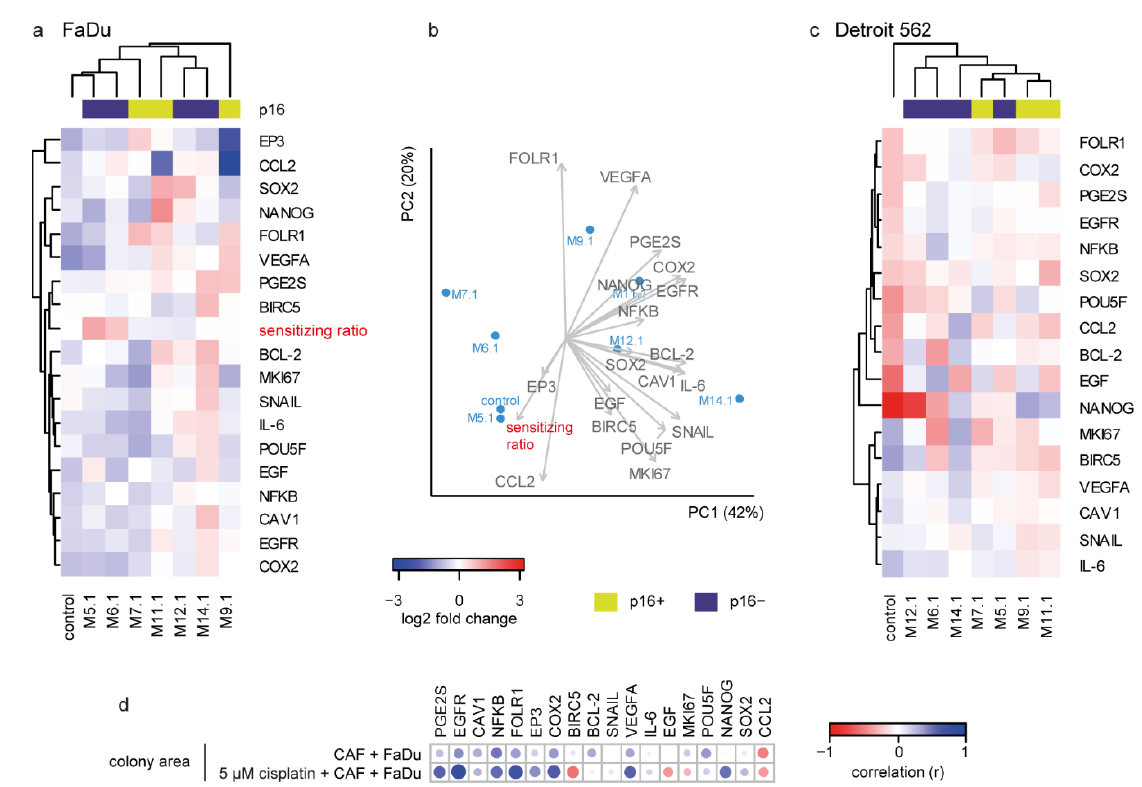
Figure 4. Effect of cisplatin on gene expression and its association with sensitizing ratio. ( a ) Heatmap of gene expression shown as a log2 fold change relative to individual CAF cocultured cisplatin untreated FaDu cells (to remove the among-CAF effect, the gene expression after coculture with each CAF (without cisplatin) was pairwise set as 0). The cisplatin effect on FaDu cell gene expression was CAF-specific and fell into two clusters: a cluster of CAFs M.5.1, M.6.1, and M.7.1 together with the non-cocultured control caused a general expression decrease and increase of cisplatin sensitivity, while M.11.1, M.12.1, and M.14.1 coculture resulted in the opposite; an increase in most of the studied genes and decreased/unchanged sensitizing ratio. ( b ) Principal component analysis of FaDu-cocultured cells. Colony-forming-based “sensitizing ratio”, EP3, and CCL2 were clustered opposite to VEGFA, PGE2S, COX2, NANOG, and EGFR. ( c ) Gene expression pattern of Detroit 562 cells cocultured with CAF-derived media; the analogue of ( a ). ( d ) Correlation of colony area with the expression of target genes in FaDu cells cocultured with CAF-derived media, with or without cisplatin. A significant positive correlation is indicated by blue, negative by red. Size of the circle corresponds to significance (bigger circle corresponds to lower p -value).